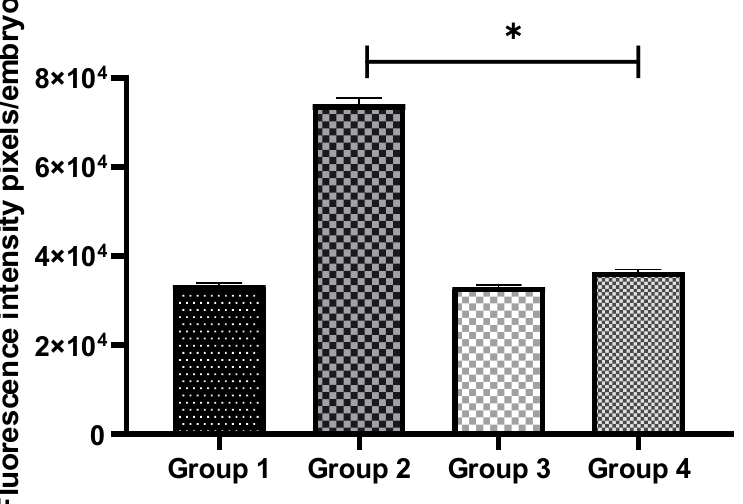
Figure 4. Comparison of intracellular ROS levels in non-vitrified and vitrified embryos. Data are expressed as the means ± SEM. * indicates p < 0.05. Data were analyzed using one-way ANOVA with post hoc Tukey multiple comparison tests. Group 1 (GSH-free medium); Group 2 (GSH-free medium with vitrification); Group 3 (0.01 mM GSH-supplemented medium), Group 4 (0.01 mM GSH-supplemented medium with vitrification).